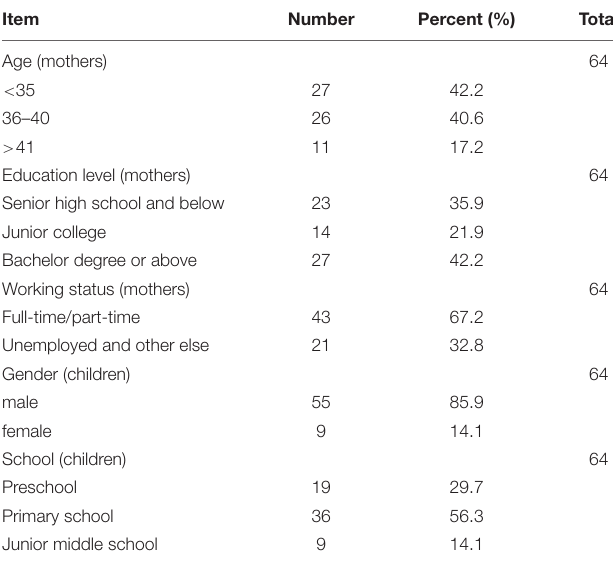
TABLE 1 | Basic characteristics of participants and their